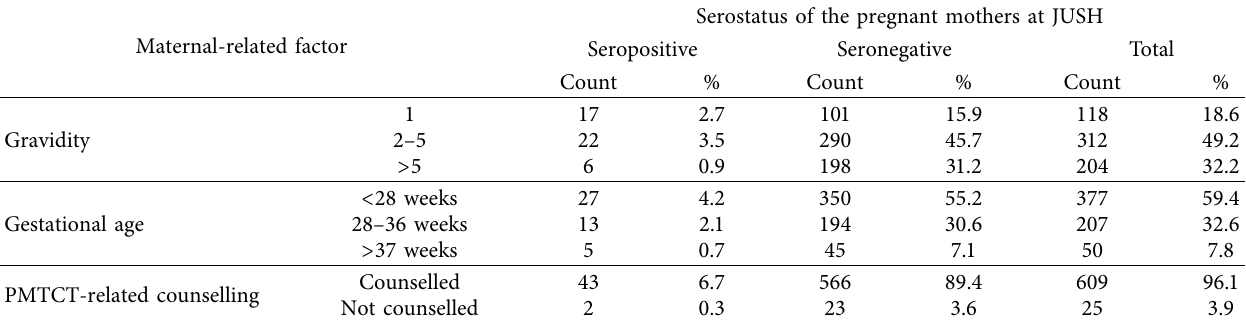
Table 2: HIV seroprevalence by maternal obstetric characteristics and male partner-related factors among pregnant mothers on ANC follow-up at JUSH.